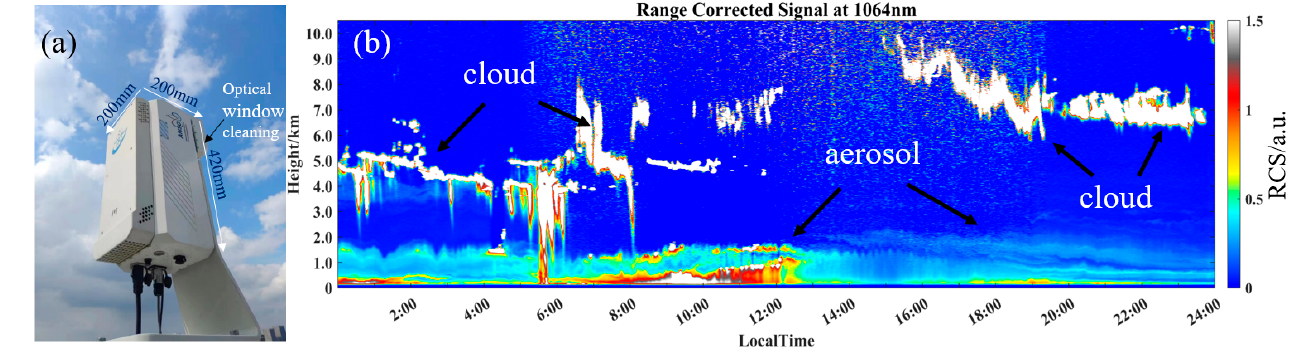
Figure 11. ( a ) Photo of mIRLidar system and ( b ) RCS profiles in vertical mode on 14 March 2022, in Hefei (UTC+8).